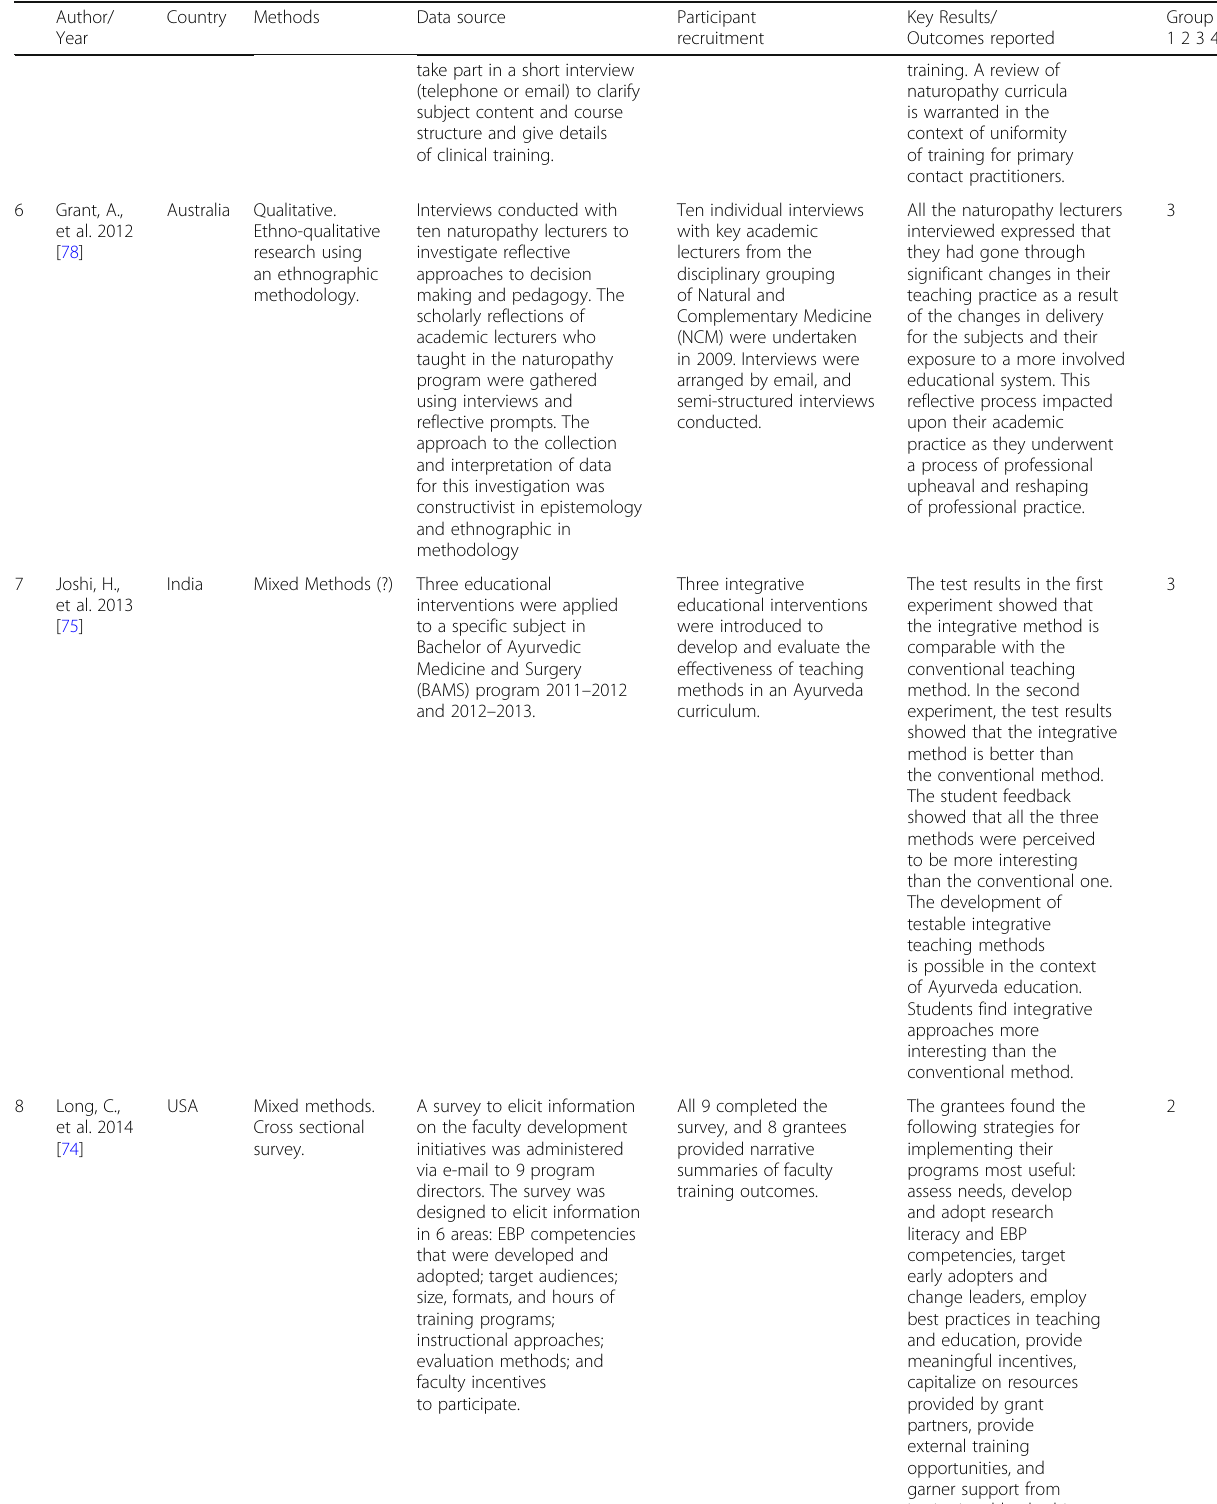
Table 2 Study Characteristics of Included Studies and Thematic Categories (1 CM education provision, 2 The development of educational competencies to develop clinical skills and standards, 3 Application of new educational theory, methods and technology in CM, 3 Future Challenges facing CM education)